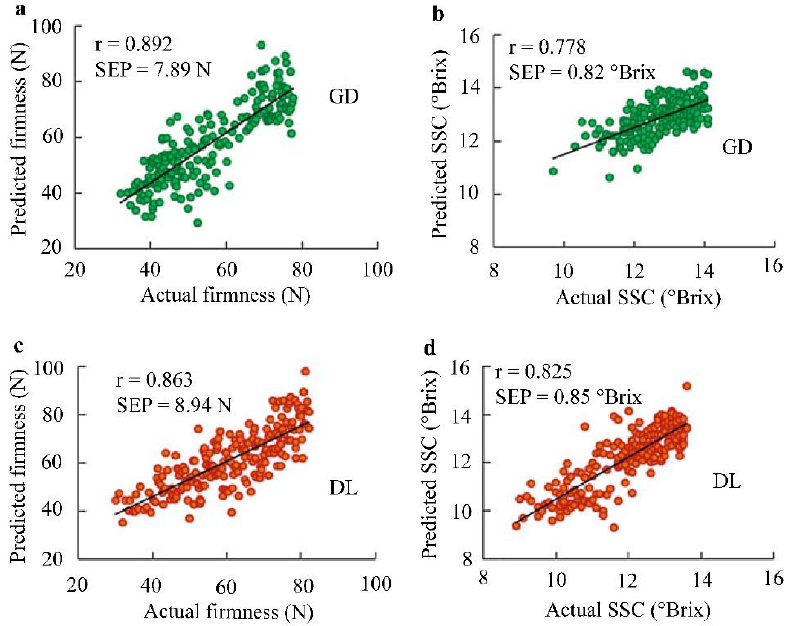
Figure 25. ( a , c ) Prediction of firmness and ( b , d ) soluble solids content (SSC) using the best combinations of µ a and µ (cid:48) s for the pooled set of ‘Golden Delicious’ (GD) and ‘Delicious’ (DL) apples.